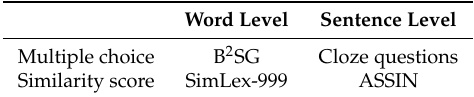
Table 9. Characterization of the benchmark